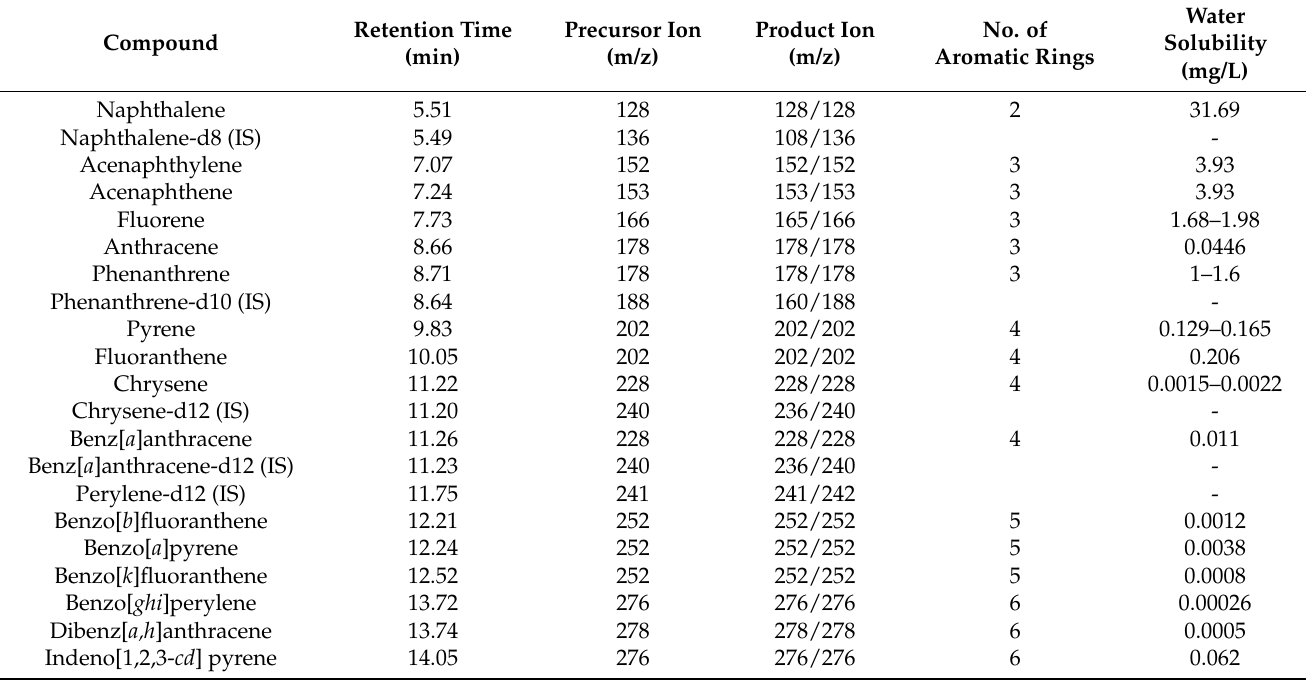
Table 1. Physico-chemical characteristics and optimized MRM acquisition parameters of target